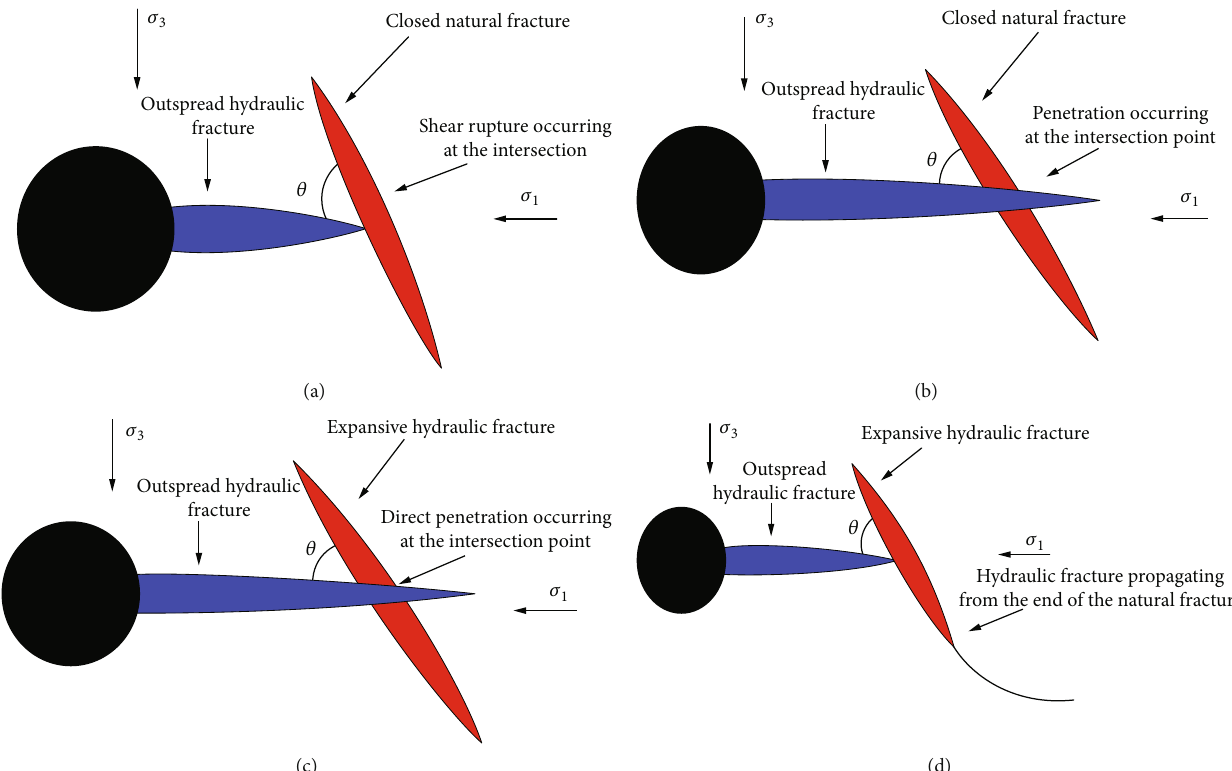
Figure 1: Plane models demonstrating the intersection of hydraulic and natural fractures. (a) Hydraulic fracture propagation when shear fracture occurs in the natural fracture. (b) Hydraulic fracture penetrates the natural fracture in the closed state directly. (c) Hydraulic fracture penetrates the natural fracture. (d) Hydraulic fracture expands from one end of the natural